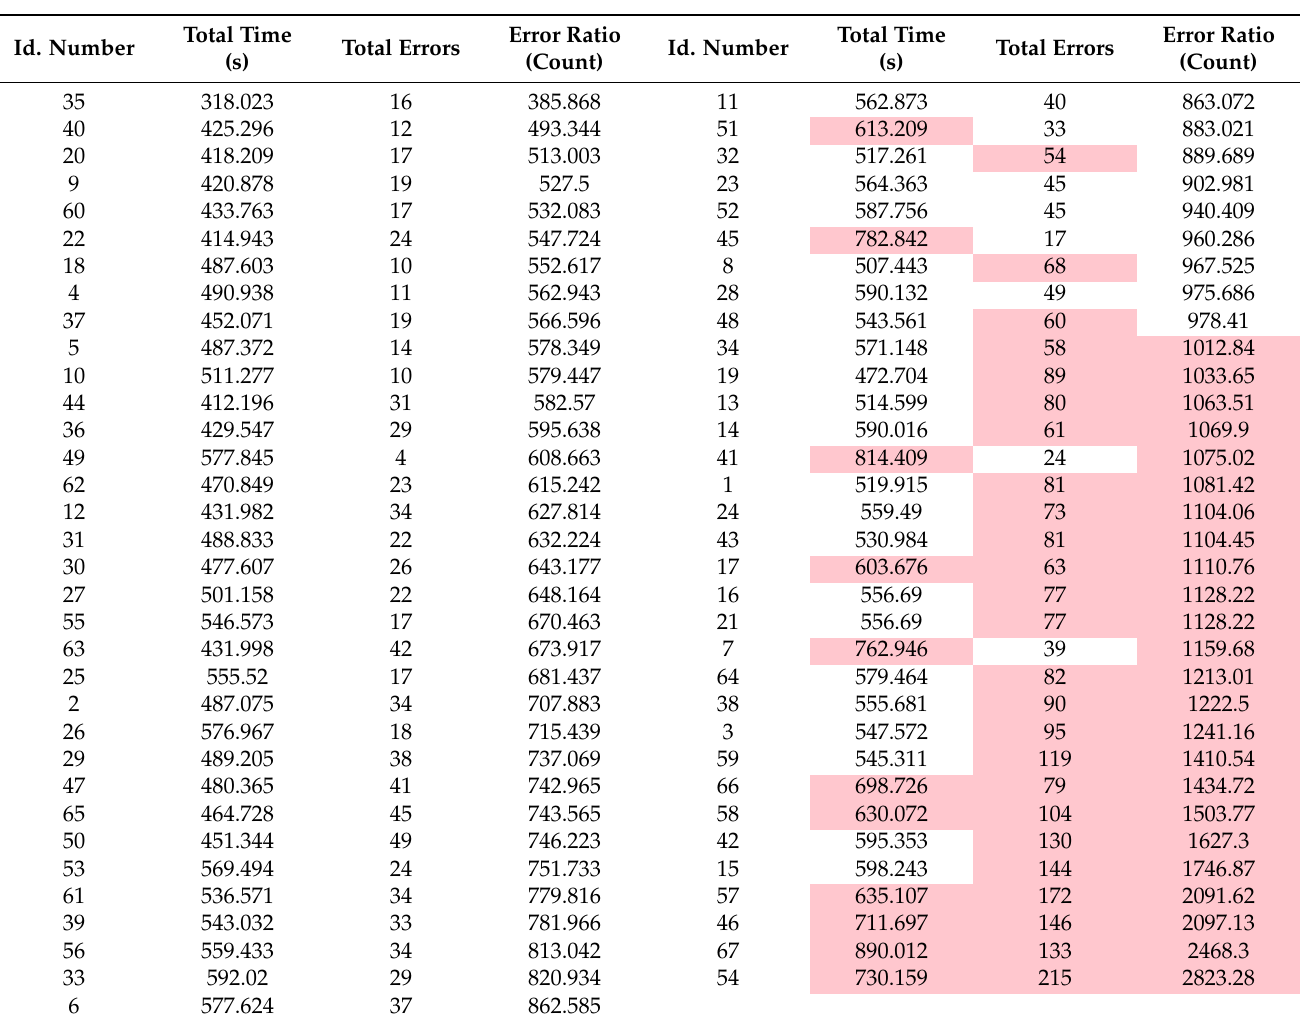
Table 2. The final sample of